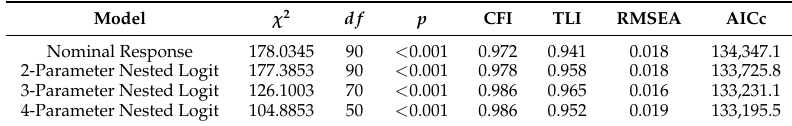
Table 3. Model fit of the nominal and nested logit models.